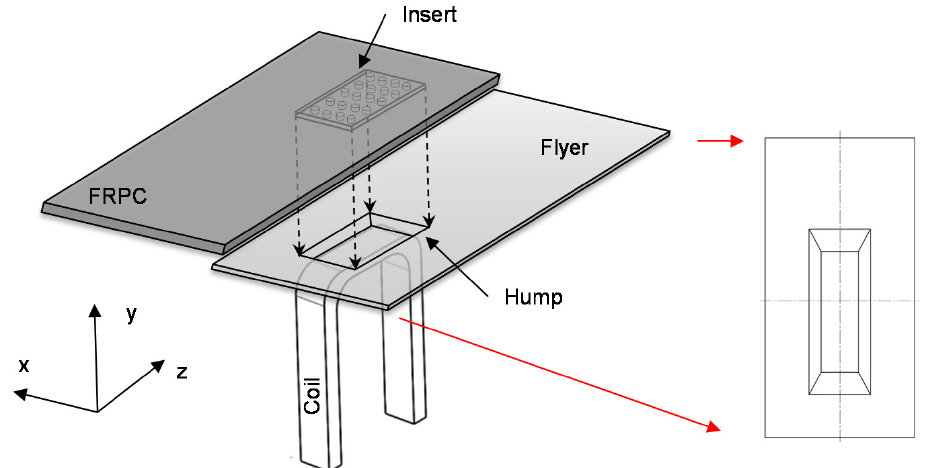
Figure 6. Magnetic Pulse Spot Welding configuration with linear coil. Note the metallic sheet with the hump is in contact with the composite insert and the deformation of the hump after the impact creates the joint.